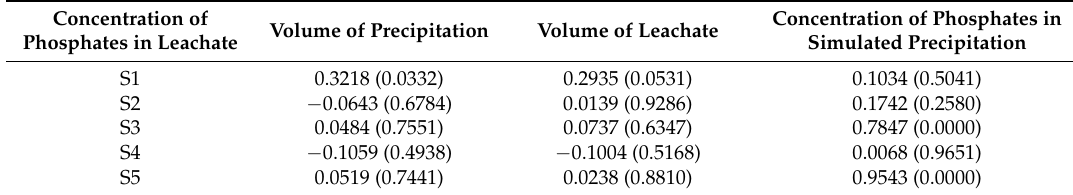
Table 3. Results of correlation analyses between phosphate concentrations in leachate S1–S5 and the volumes of precipitation, volumes of leachate, and concentration of phosphates, presented as Pearson correlation coefficient r and probability p (in brackets). p -values below 0.05 indicate statistically significant non-zero correlations at the 95.0% confidence level.